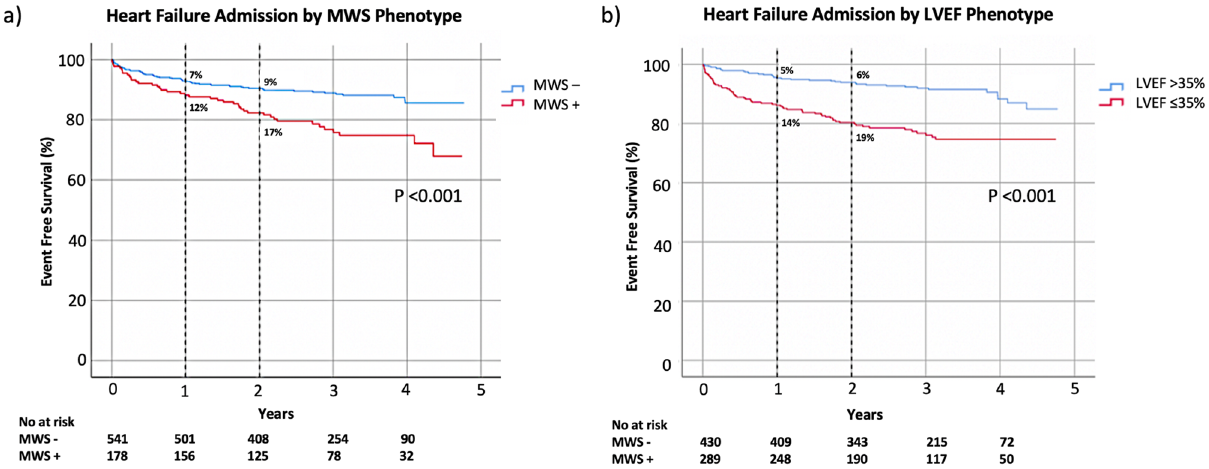
Figure 2. Kaplan–Meier event free survival curve for the primary outcome of heart failure hospitalization in patients with and without ( a ) mid-wall striae (MWS) fibrosis, and ( b ) LVEF ≤